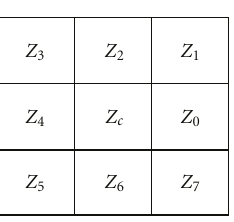
Figure 1: A 3 × 3 pixels